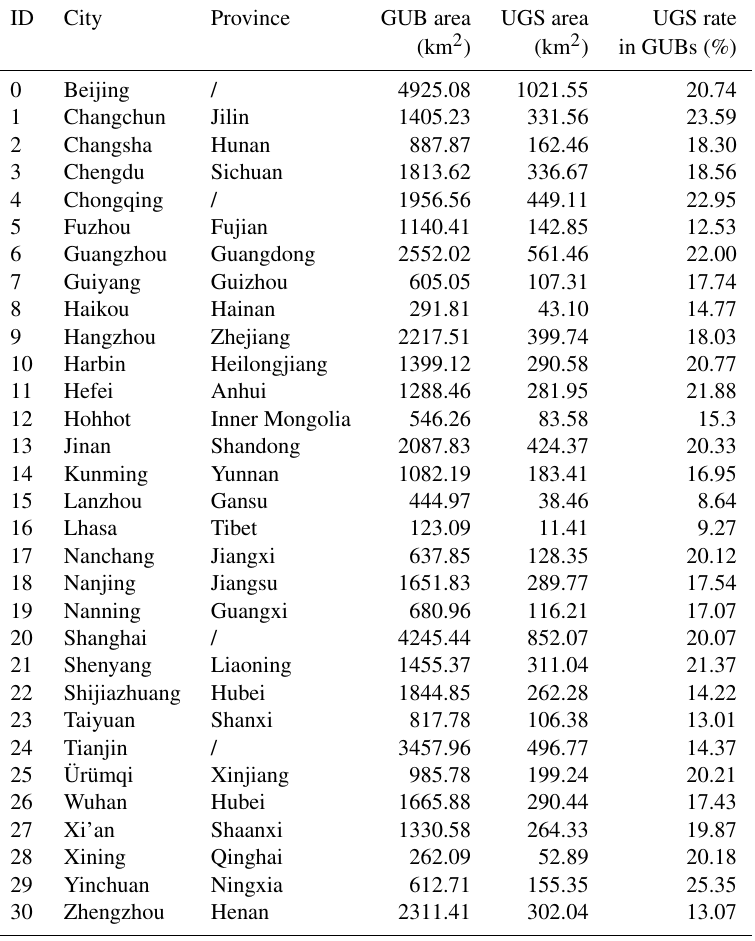
Table 4. Statistical results of UGS-1m in the UGS area and rate for 31 major cities in China.